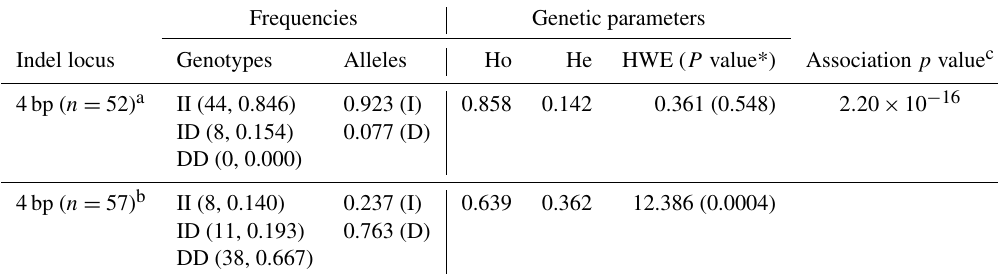
Table 3. Genetic parameters and association analysis of the 4bp indel of the RAI14 gene. Frequencies